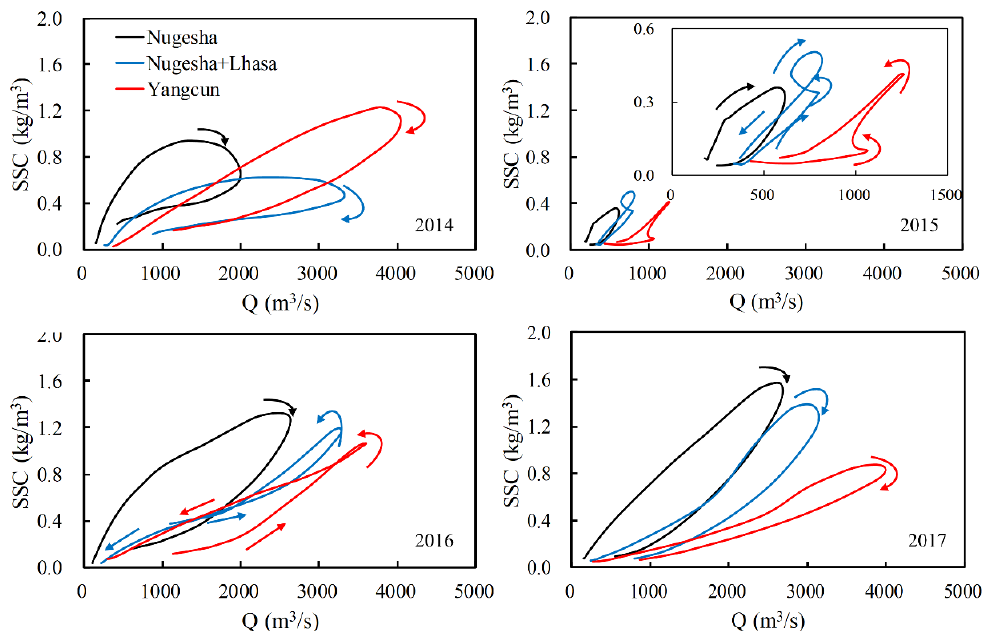
Figure 10. Q-SSC hysteresis in the mainstream in response to the inflow of the Lhasa River. Table 6. Land-use changes in the N–Y sub-catchment in 2010 and 2018.